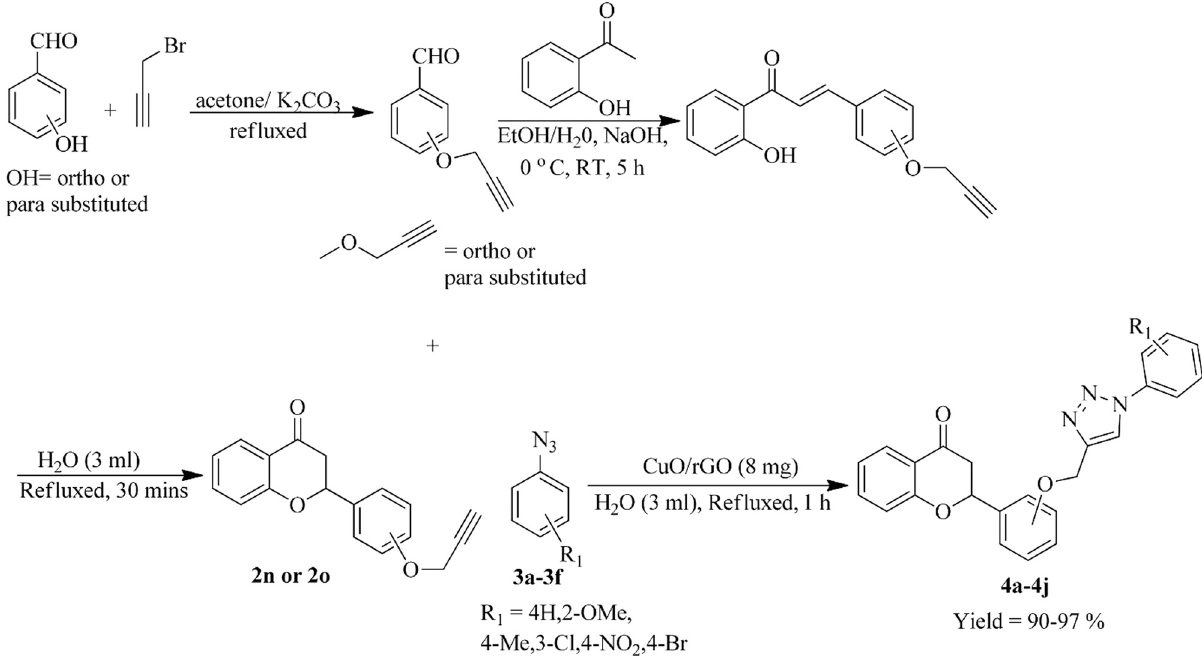
Scheme 6: General scheme for 1,2,3 - triazoles. Reproduced by permission of The American Chemical Society. ACS Omega 2018;3 ( 7 ) :7288 – 99, https://pubs.acs.org/doi/10.1021/acsomega.8b00334. Notice to readers: further permissions related to the material excerpted should be directed to the